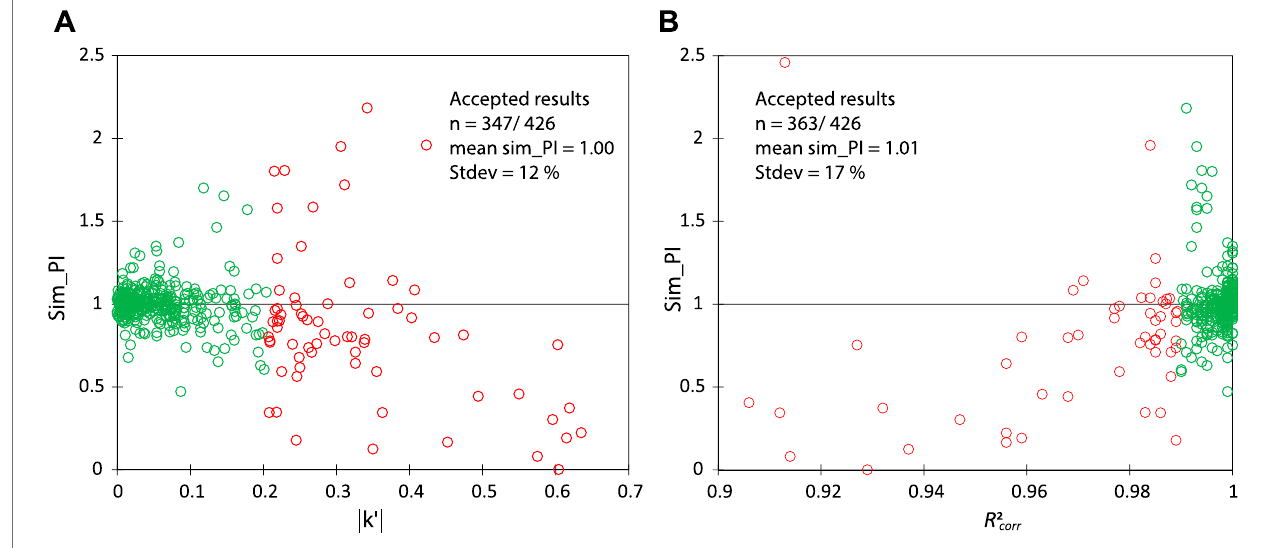
Frontiers in Earth Science |